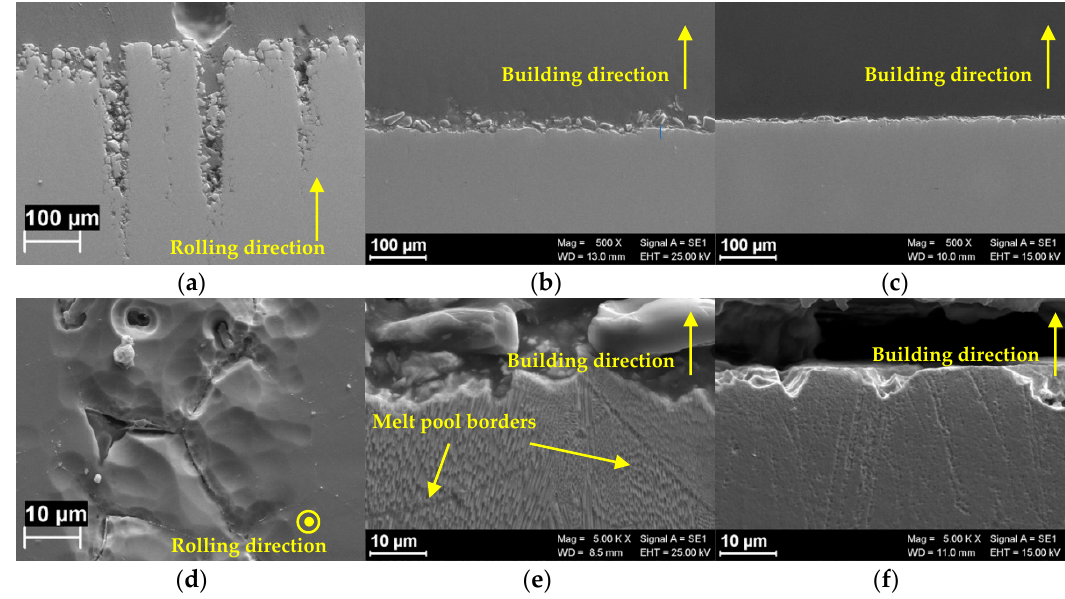
Figure 2. SEM images of Alloy 625 after intergranular corrosion tests. Metallographic section of commercial rolled alloy along the rolling direction ( a ) detail of the attack on the surface perpendicular to the rolling direction ( d ). Metallographic section of LPBF alloys along the building direction in as produced conditions ( b , c ) and after heat treatment ( e , f ).